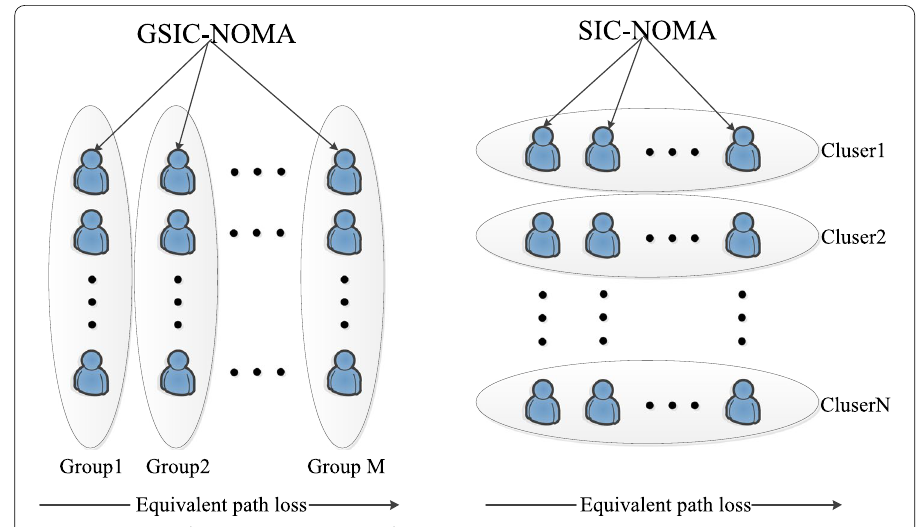
Fig. 2 Comparison between GSIC-NOMA and